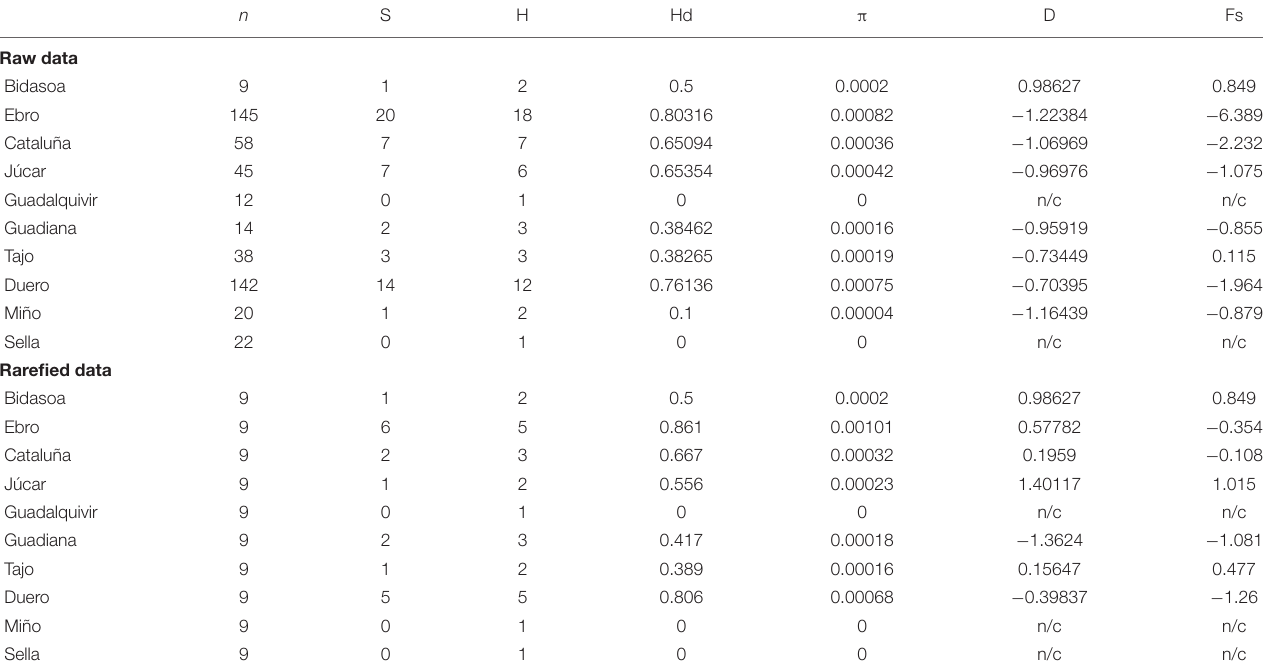
TABLE 3 | Genetic diversity within white-clawed crayfish hydrogeographic catchments in the Iberian Peninsula for the raw and rarefied data. n S H Hd π D